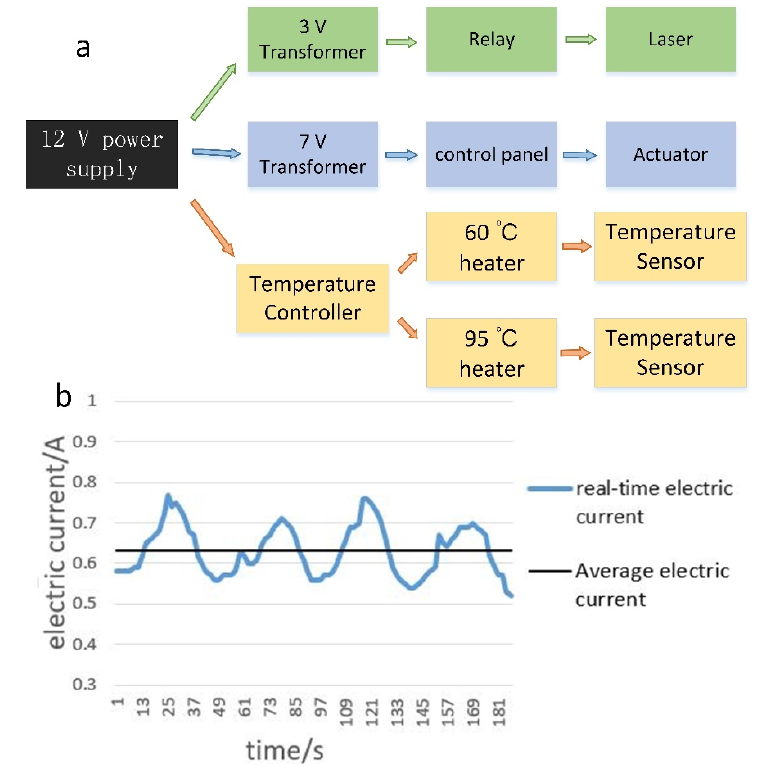
Figure 3. ( a ) Power supply shunt diagram. ( b ) Current variation at 12 V over two cycles.